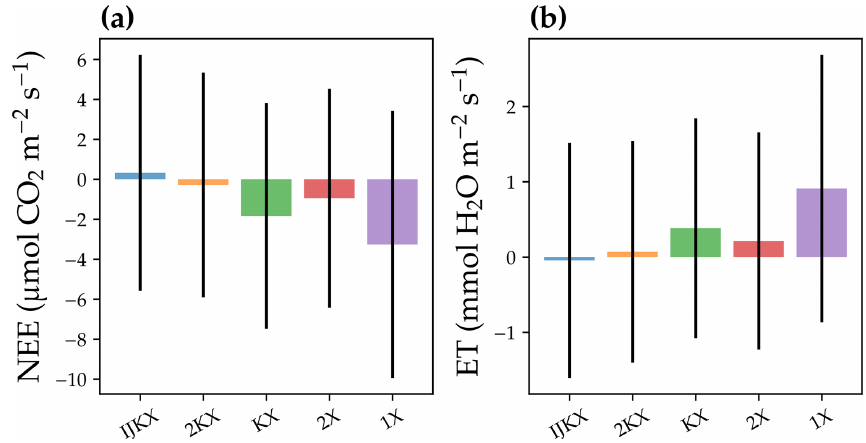
Figure 8. Difference between five different canopy complexity levels in a diurnal-cycle simulation of carbon and water fluxes. The carbon flux was represented by the site-level net ecosystem exchange of CO 2 (NEE). The water flux was represented by site-level evaporation transpiration using plant transpiration as a proxy (ET). The bars plot the mean difference between model simulation and observations, and error bars plot 1 standard deviation. The observation was from a flux tower at Ozark, Missouri, USA (US-MOz). The model simulations were run with a profile of vertical leaf photosynthetic capacity using observed weather drivers from day 177 to 179 in the year 2019, such as air and soil humidity. For NEE, negative values stand for overestimated carbon fluxes; for ET, positive values stand for overestimated water